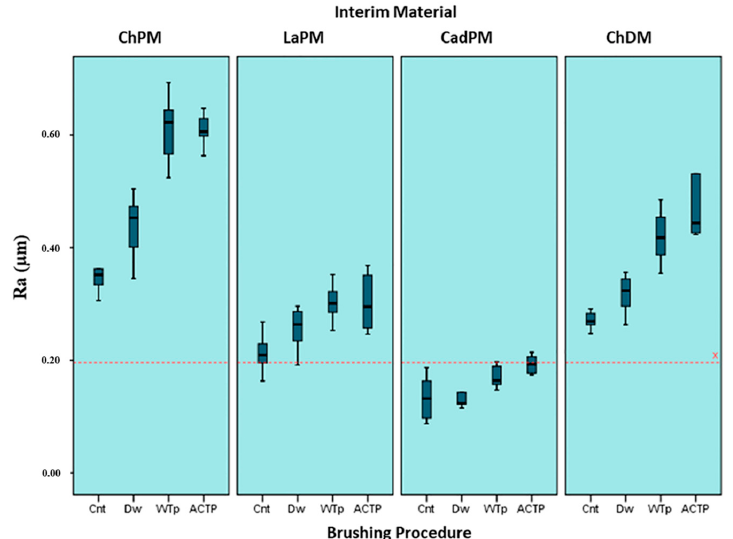
Figure 3. Mean R a ( ± SD) values of the test groups. The plaque accumulation threshold (R a = 0.2 mm) is indicated as line-x.